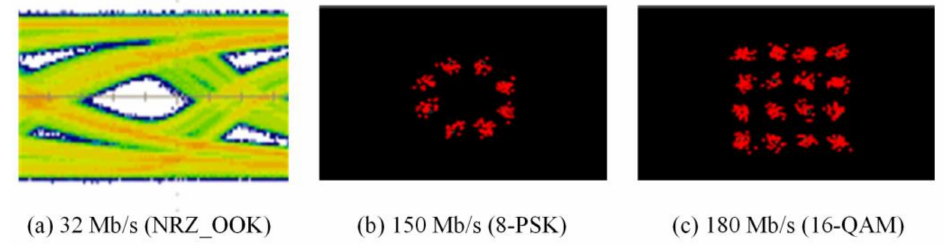
Figure 10. Pure data transmission rate of Red LED with bandpass filter (BER = 10 − 3 ).